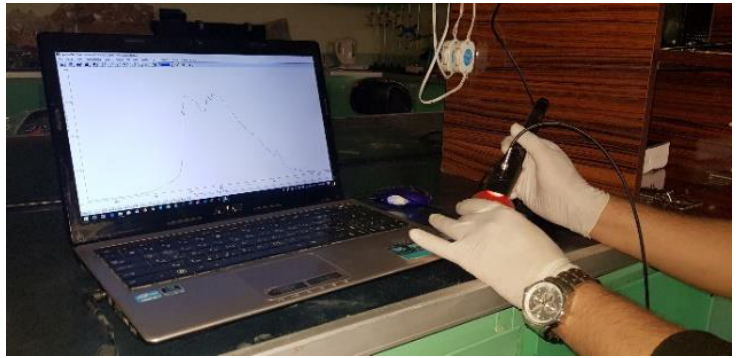
Figure 1. Measurement of VIS/near infrared (NIR) spectra of tomato samples.